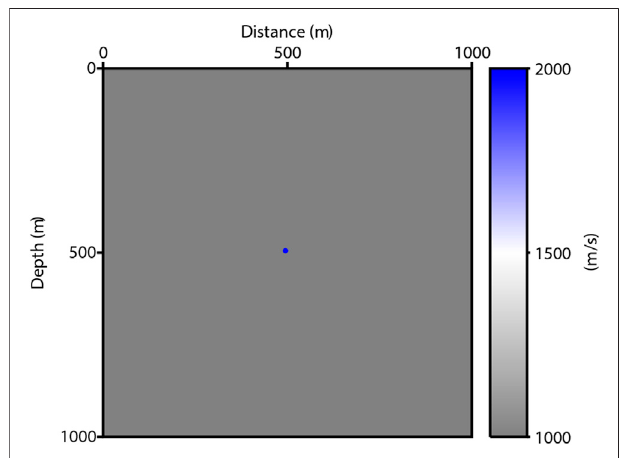
FIGURE 3 | Schematic diagram of the Pareto curve. A Newton-based root- fi nding method is used to update the solution of Eq. 20 .